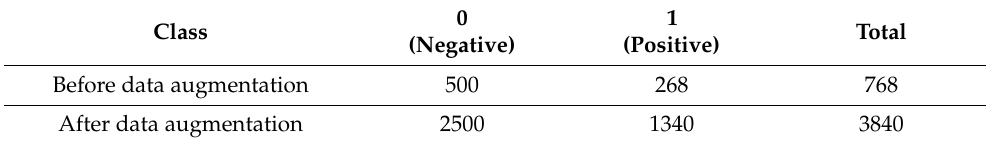
Table 3. Examination of all data before and following data augmentation.